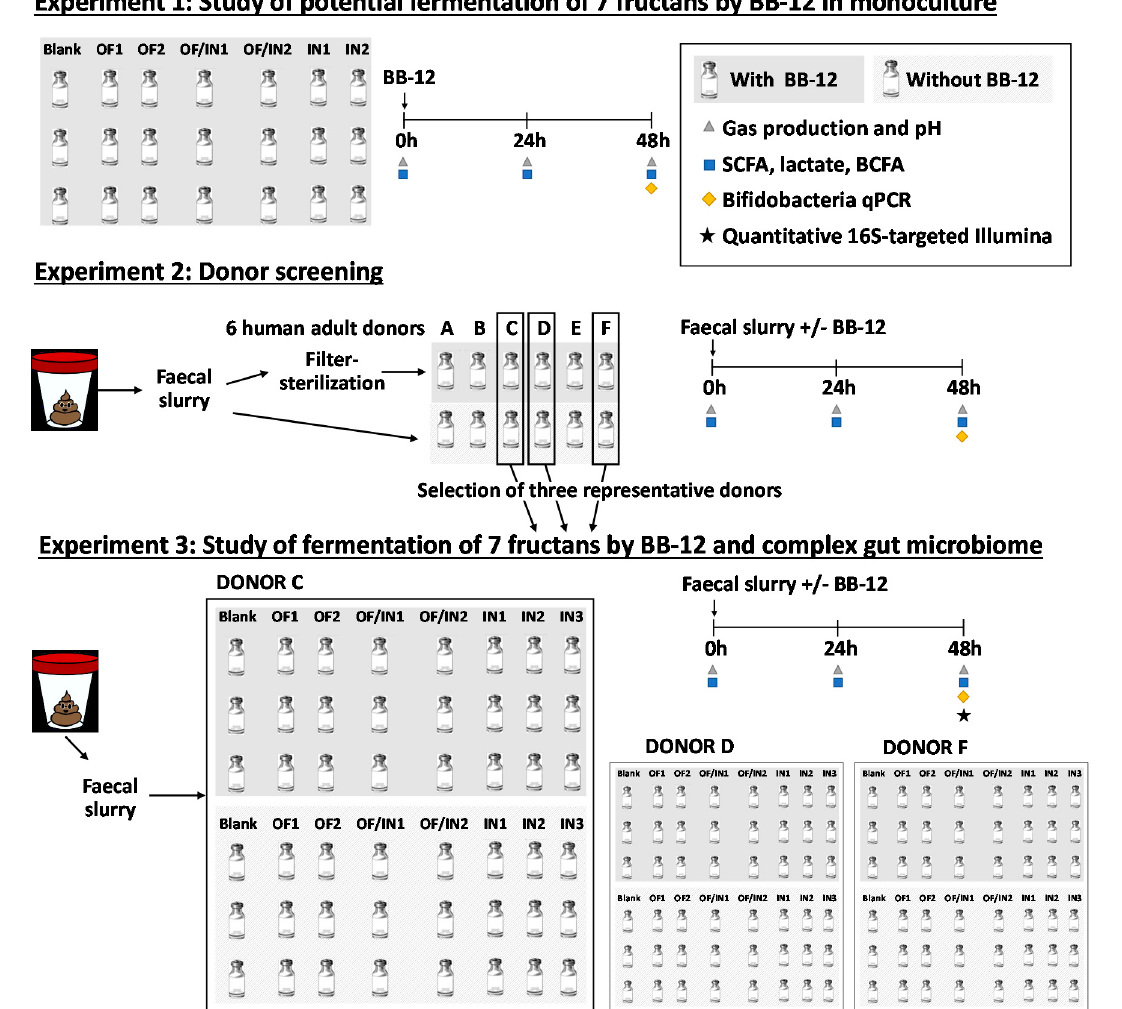
Figure 1. Schematic representation of the in vitro approach to investigate the synbiotic potential of fructan-type carbohydrates and BB-12. First, potential fermentation of seven fructan-type carbohydrates by BB-12 was investigated in monoculture incubations (experiment 1). In experiment 2, a donor screening was performed for six human faecal donor samples. In experiment 3, short-term colonic incubations were performed to characterize the synbiotic potential of the fructan-type carbohydrates combined with BB-12 and complex microbiota of three selected human donors. Samples were collected to evaluate the effect of the test products on microbial metbaolic activity (pH, gas production, SCFA, lactate and bCFA) and community composition (Bifidobacteria qPCR and quantitative 16S-targeted Illumina sequencing). BB-12 = Bifidobacterium animalis subsp. lactis; OF = oligofructose; IN = inulin; SCFA = short-chain fatty acids; bCFA = branched-chain fatty acids; qPCR = quantiative polymerase-chain reaction.